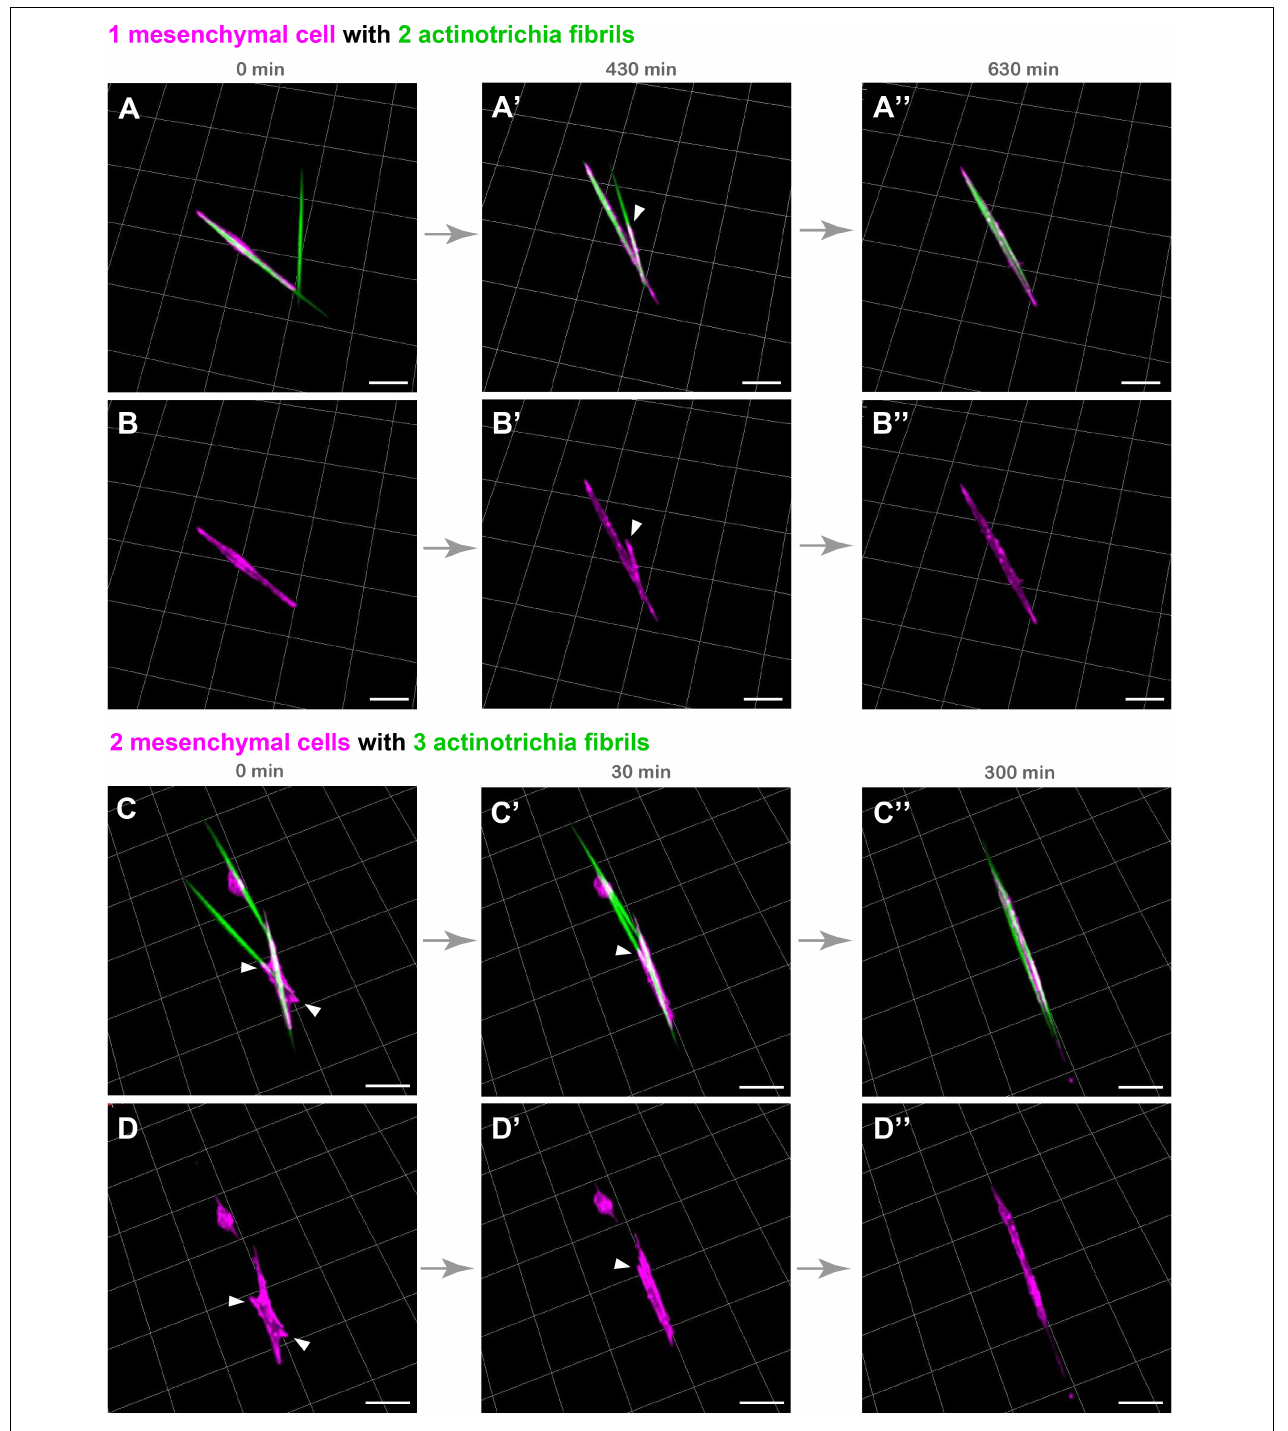
FIGURE 4 | Live cell imaging of cultured mesenchymal cells holding the actinotrichia fibrils. Captured time-lapse images for the interaction between mesenchymal cells and actinotrichia fibrils. Mesenchymal cells and actinotrichia were isolated from the fins of F1 TG larvae [TG; 5 x and1 (MC): Lifeact-mCherry/5 x and1 (2P): And1 full -GFP] and cultured on a Matrigel-coated dish. (A) A single mesenchymal cell initially surrounded one of two different actinotrichia fibrils. (A (cid:48) ) At 430 min, the mesenchymal cell started to develop a filopodia like structure (white arrowheads) and to hold another fibril. Finally, (A (cid:48)(cid:48) ) at 630 min, two fibrils were completely aligned in the direction of the longitudinal axis of the mesenchymal cell. The fluorescence images of only a mesenchymal cell are shown in the bottom panels (B–B (cid:48)(cid:48) ) . (C) Two mesenchymal cells initially developed their pseudopodia (white arrowheads) and attached to three different fibrils, and (C (cid:48) ) gradually changed their morphology and moved the fibrils. (C (cid:48)(cid:48) ) At 300 min, the two cells extended in the same direction and all of three fibrils were oriented along the longitudinal axis of the two mesenchymal cells. The fluorescence images of only two mesenchymal cells are shown in bottom panels (D–D (cid:48)(cid:48) ) . Scale bars: 20 µ m.